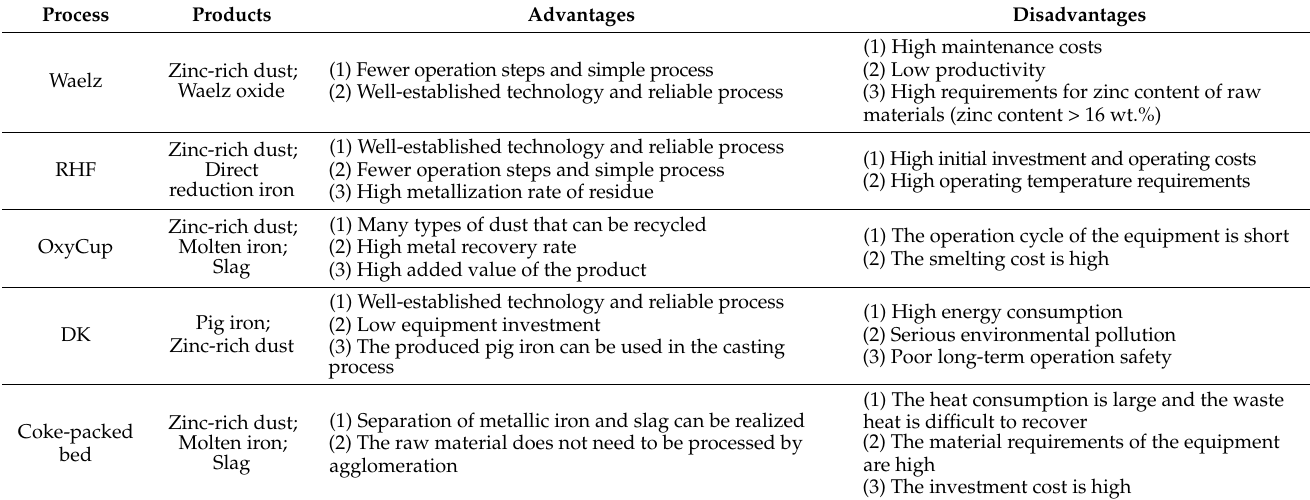
Table 3. Comparison of different pyrometallurgical processes [8,13,32–35].